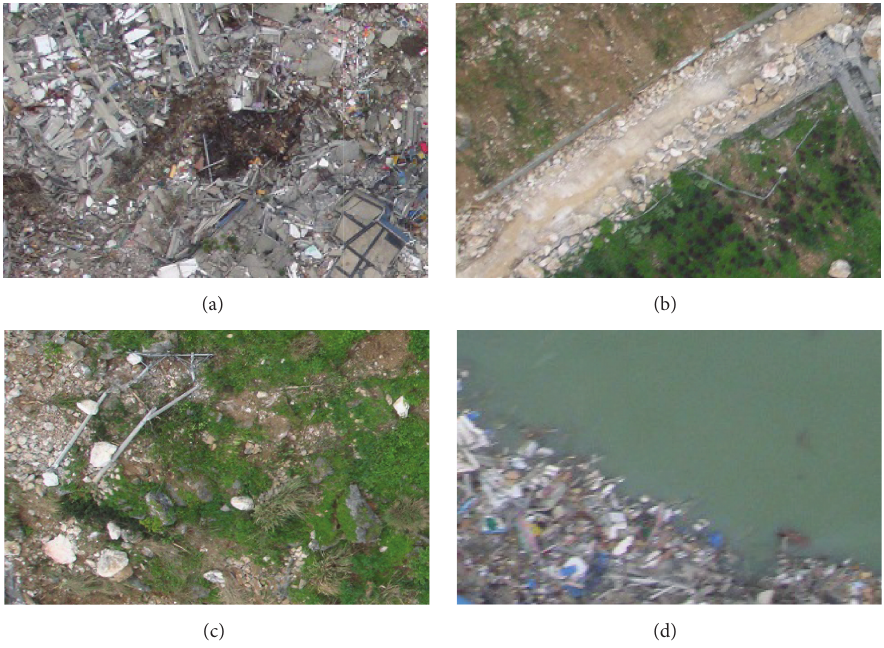
Figure 5: The aerial image samples of typical ground targets.